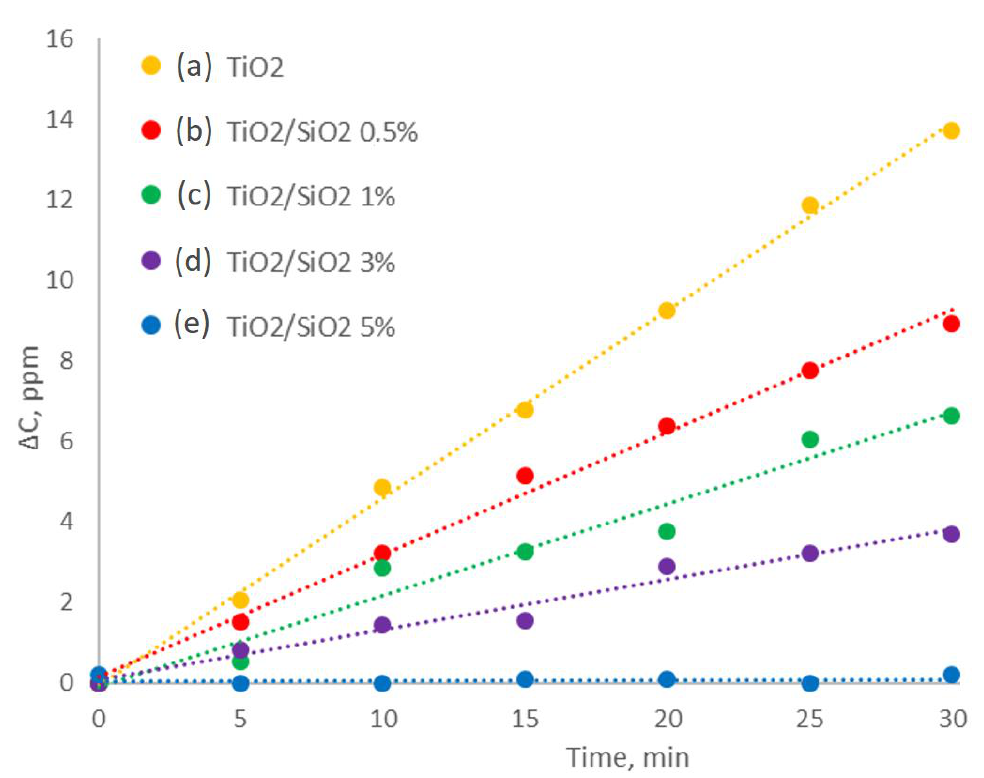
Figure 5. Measured photocatalytic activity of ( a ) TiO 2 100% and TiO 2 /SiO 2 multicompound nanoparticles with ( b ) TiO 2 /SiO 2 99.5/0.5, ( c ) TiO 2 /SiO 2 99.0/1.0, ( d ) TiO 2 /SiO 2 97.0/3.0 and ( e ) TiO 2 /SiO 2 95.0/5.0 after tribological wear.